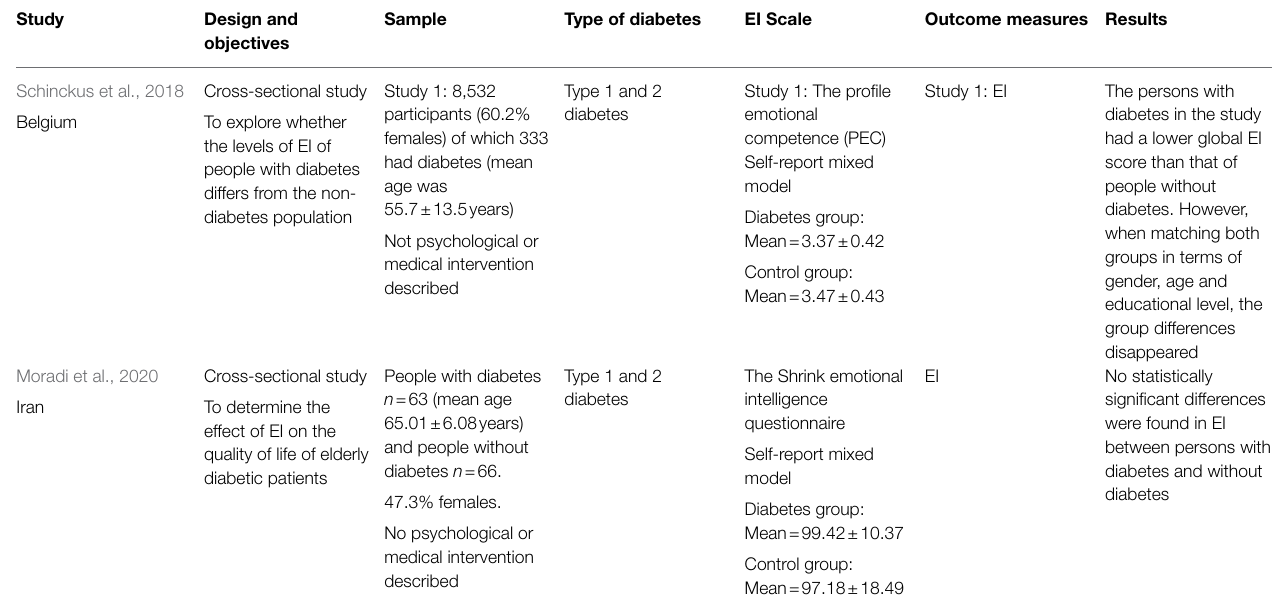
TABLE 4 | Studies analyzing differences between people with diabetes and without